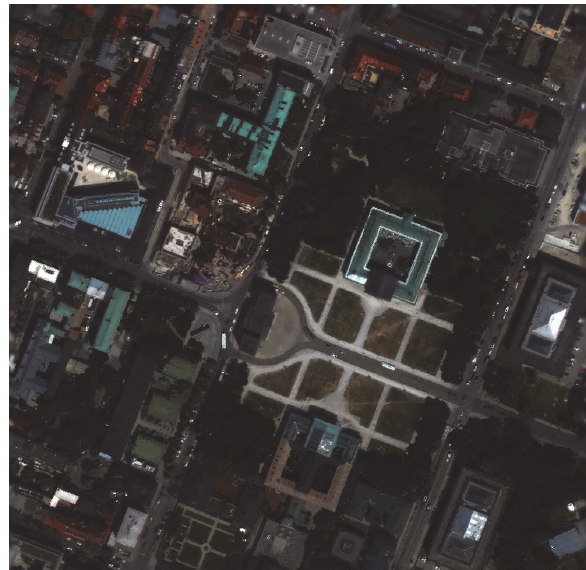
Figure 6. Reconstruction using spatial unmixing (31).